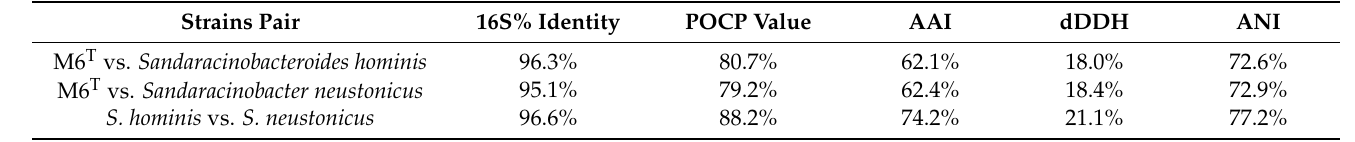
Table 1. The 16S rRNA gene similarity, POCP, AAI, ANI, and dDDH values between M6 T and its closely related strains available with genome